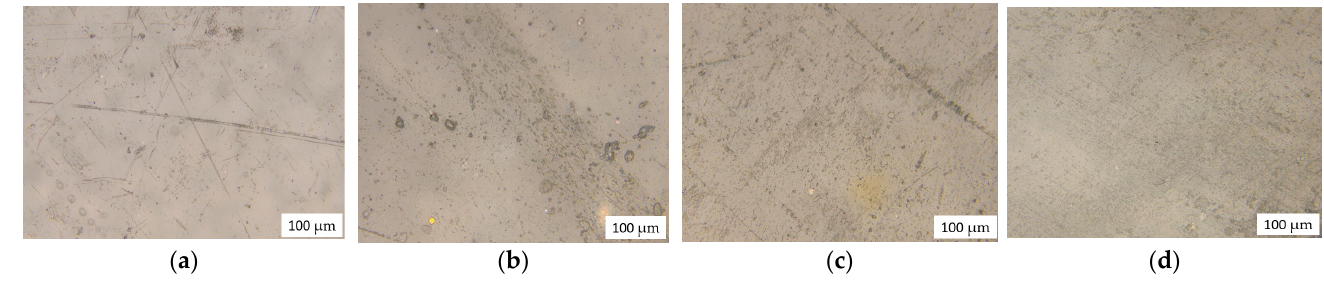
Figure 2. The microphotographs of initial samples: LDPE 100 ( a ), LDPE/NR 90/10 ( b ), LDPE/NR 70/30 ( с ), LDPE/NR 50/50 ( d ).